Question: How would you classify this visualization?
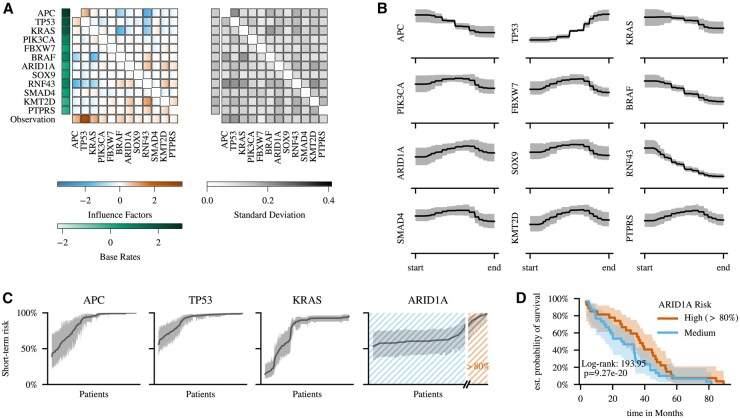
Answer: survival